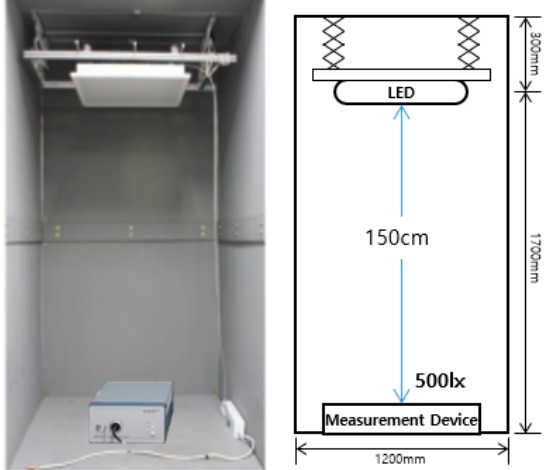
Figure 5. Environment for measuring optical characteristics.